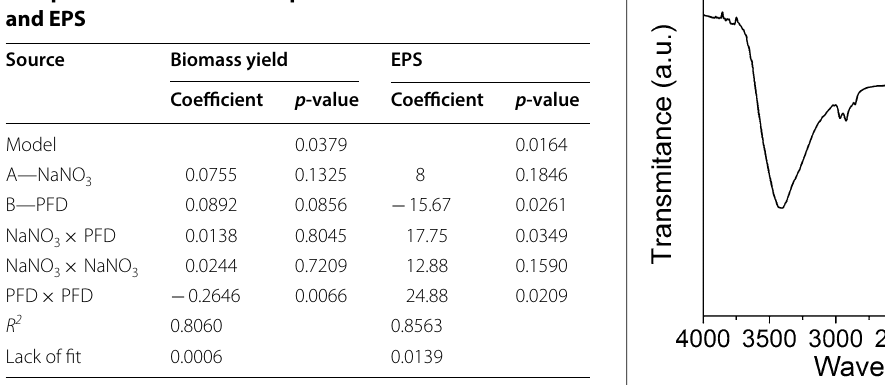
Table 2 R 2 , lack of fit, p -value, coefficients and effects on quadratic model to responses obtained of biomass